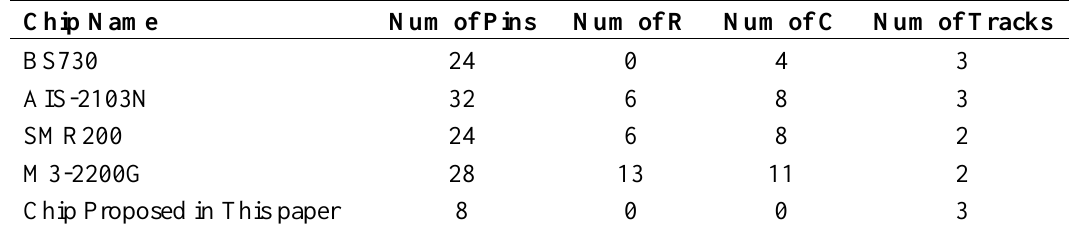
Table 1. The differences of these five